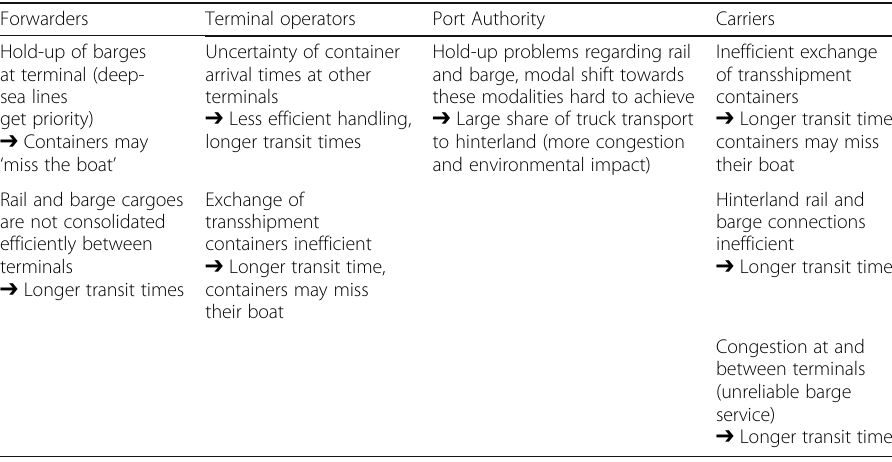
Table 1 Inventory of problems in inter-terminal coordination (and their effects on performance), as identified by respondents